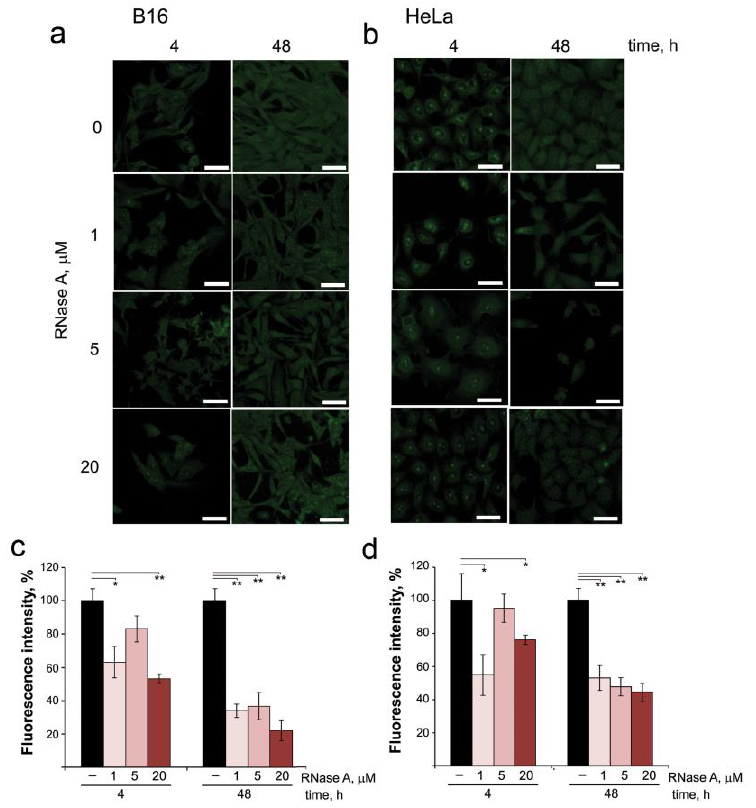
Figure 3. The effect of RNase A on the content of intracellular RNAs in B16 and HeLa cells. ( a,b ) Images of B16 and HeLa cells, respectively, after incubation for 4 or 48 h in the presence of RNase A (1, 5 and 20 µM). Cells were stained with SYTO RNASelect and analyzed using confocal microscopy. ( c , d ) The fluorescence intensity of intracellular RNAs in B16 and HeLa cells, respectively, evaluated using ImageJ software. Data are presented as mean ± S.E.M. Statistical processing of the data was carried out using Student’s t -test; * p < 0.05, ** p < 0.01. Scale bars: 10 µ